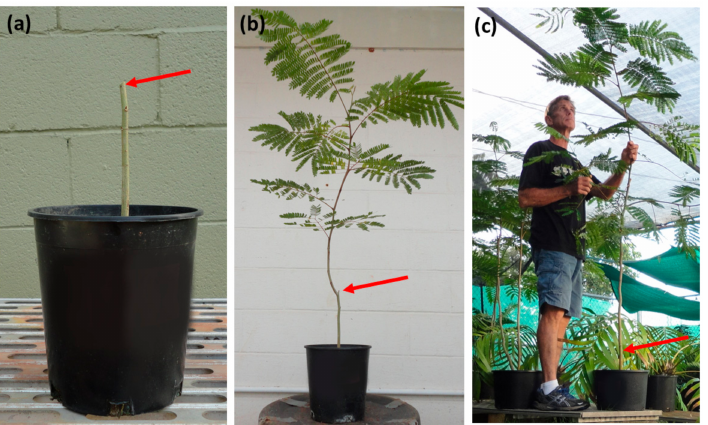
Figure 2. Recovery of Serianthes plants from heading back pruning is rapid if a plant physiologist is available to manage the water relations decisions. ( a ) Three-month-old S. grandiflora seedling pruned to 15-cm height on 3 August 2015; ( b ) Same plant at 56 cm height on 15 September 2015. ( c ) Same plant at 203 cm height on 26 February 2016. Red arrows point to the position of initial pruning. Three more stem pruning steps were administered for a total of four pruning steps, each followed by restrictive irrigation and protection from